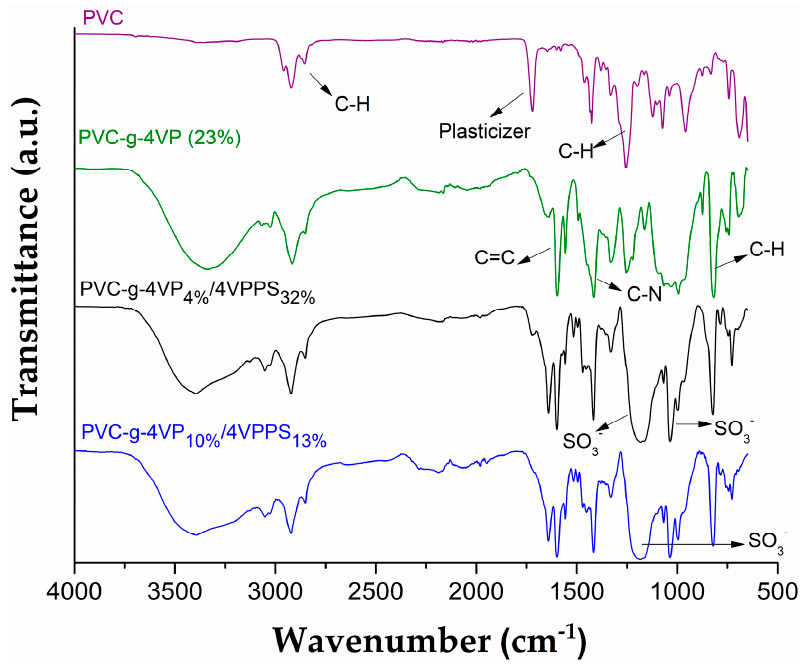
Figure 3. Infrared spectra of the neat and grafted PVC catheters using ATR module .